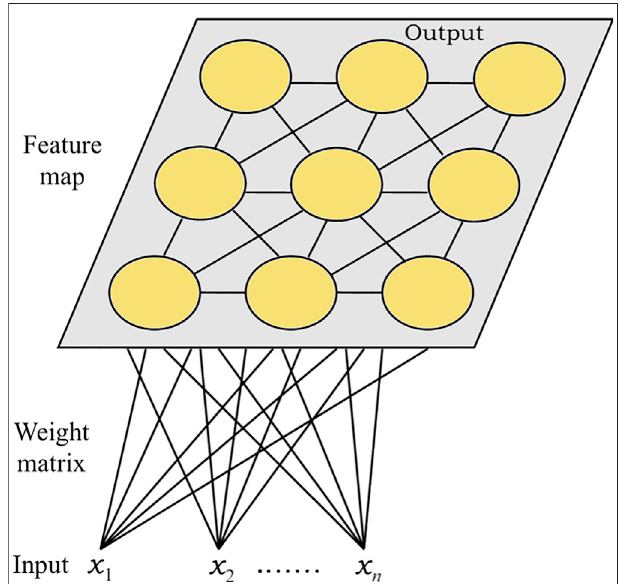
FIGURE 3 | Example of the architecture of a Self-Organizing Map. The network has two layers: the input and the output layer, with the nodes of the input layer directly connected to those of the output